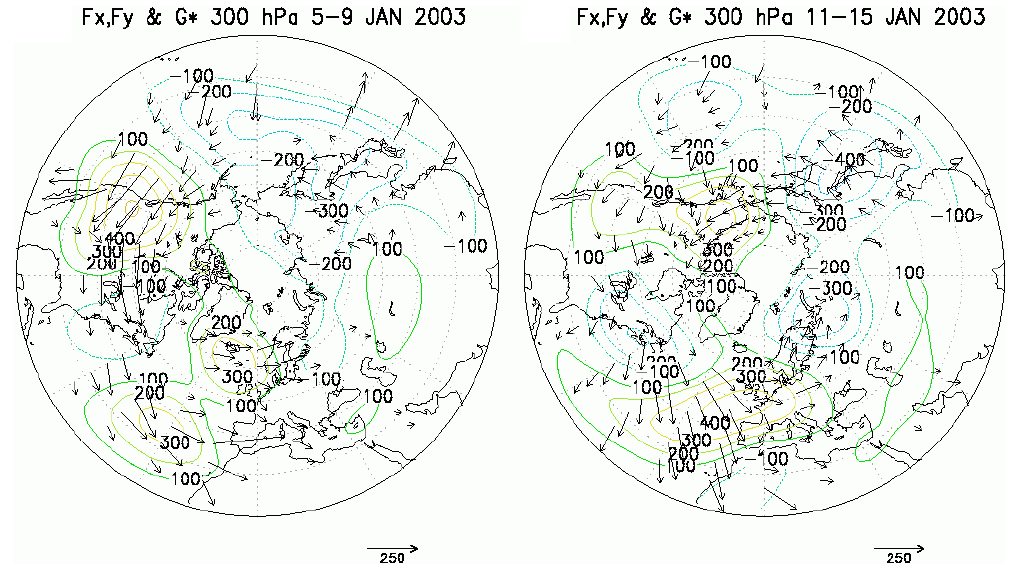
Figure 9: Stereographic projection of the zonal wind at 300 hPa for the period 1-5 (a) and 7- Fig. 10. Stereographic projection of geopotential height perturbation G * (dam) and horizontal Plumb flux vector (m 2 s − 2 ) at 300hPa for the Figure 10: Stereographic projection of geopotential height perturbation G* (dam) and period 5–9 (left) and 11–15 January 2003 11 January 2003 (b). Values > 30 m s -1 are colored. horizontal Plumb flux vector (Fx, Fy) (m 2 s -2 ) at 300 hPa for the period 5-9 (left) and 11-15 January 2003 (right).